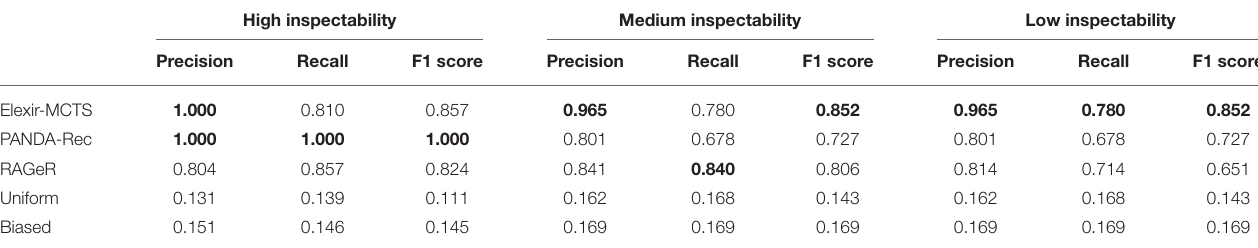
TABLE 3 | Macro Precision, Recall, and F1 scores for Elexir-MCTS, PANDA-Rec, RAGeR, and two baselines (Random Uniform and Biased recognition). High inspectability